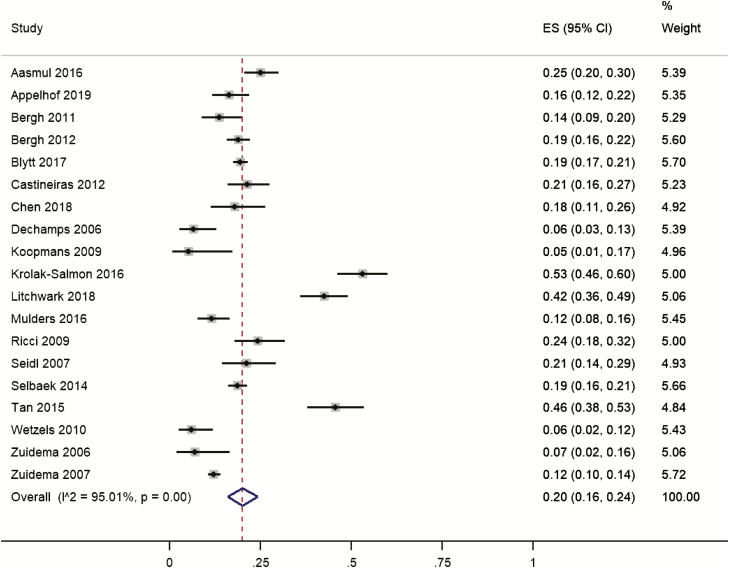
Forest plot of the prevalence of clinically significant sleep disturbances in people with dementia living in care homes measured by validated questionnaires. ES, effect size.